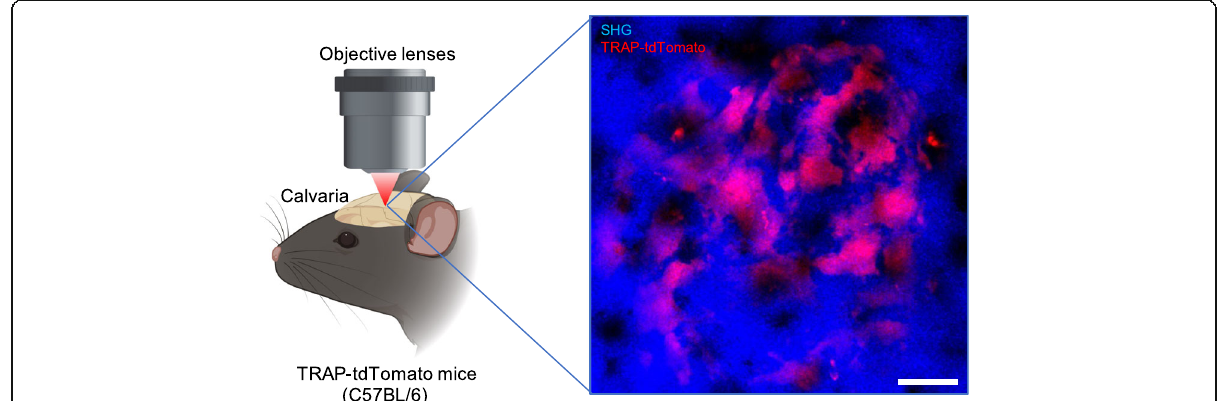
Fig. 2 Observation of osteoclasts in the bone marrow. Osteoclasts were observed using an upright two-photon microscopy. This is a representative result. Blue: second-harmonic generation (SHG), Red: TRAP-tdTomato, Scale bar: 30 μ